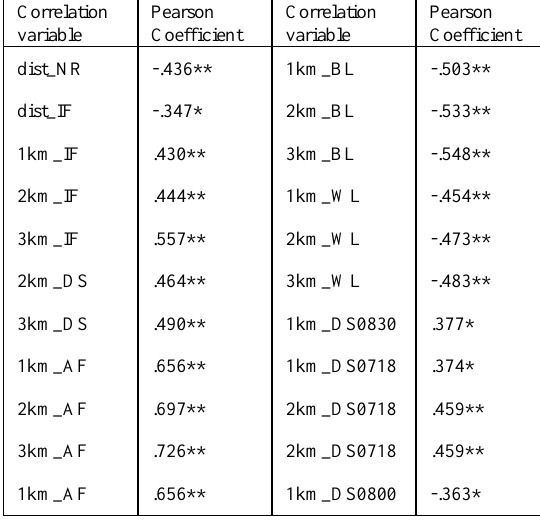
Tab.1 Correlation analysis results between PM 2.5 and its significantly related variables * * indicates a significant correlation at the 0.01 level (bilateral), and * indicates significant correlation at the 0.05 level (bilateral).